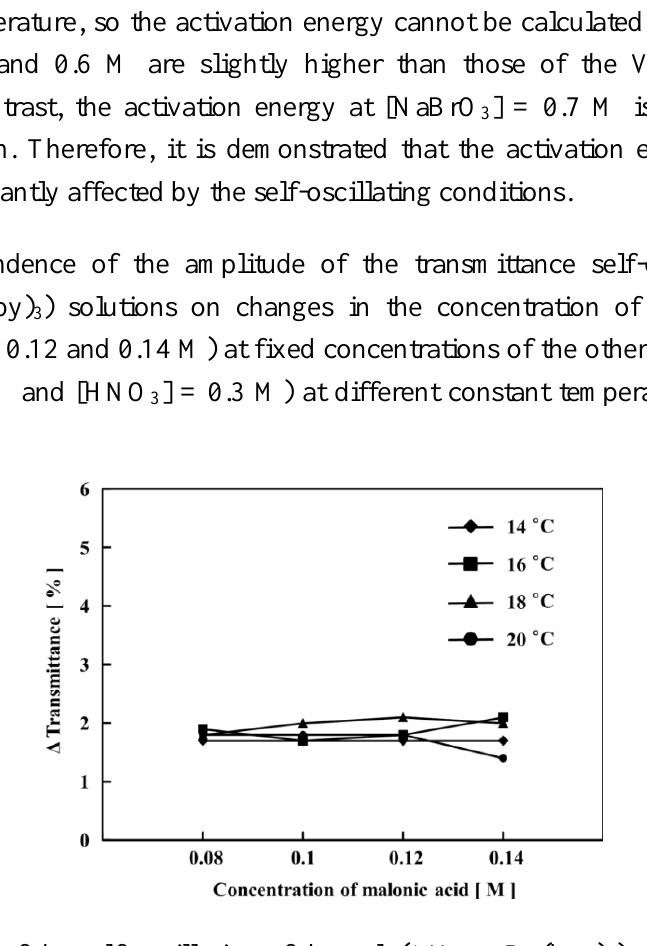
) polymer solution as 3